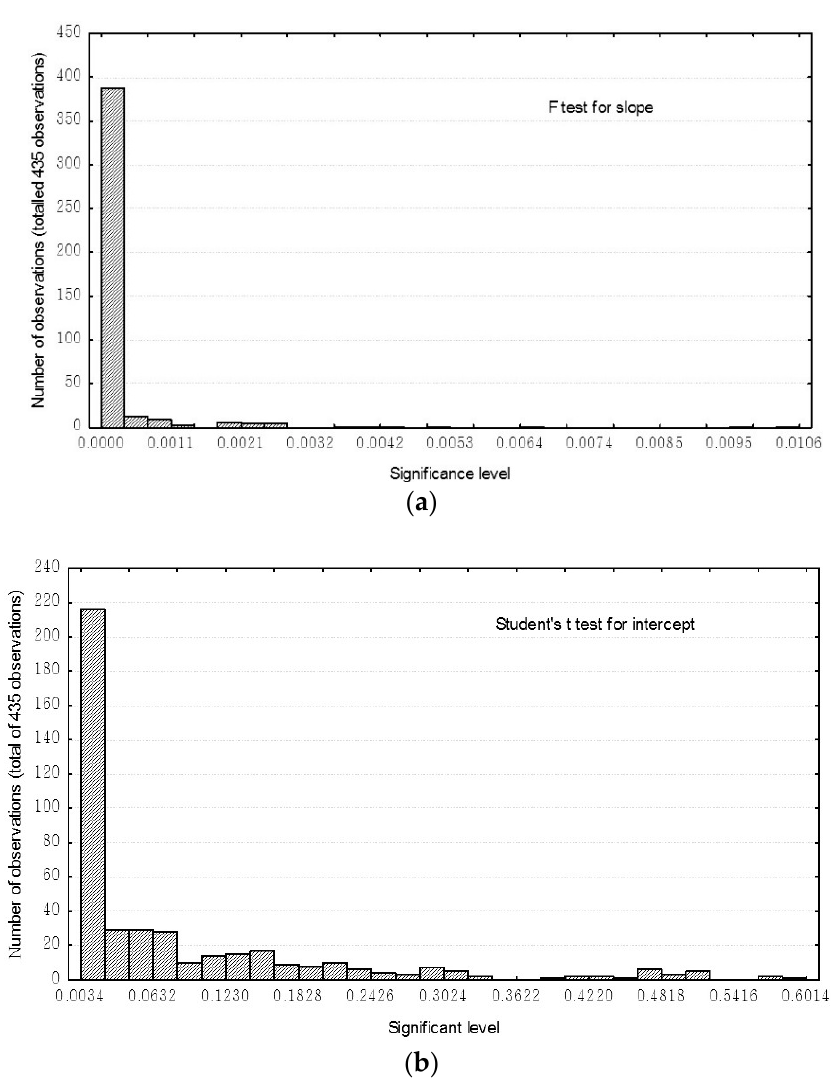
Figure 3. Distributions of significant level of the slope and intercept of the regression of fire probability over IC for periods with different time spans. ( a ) denotes the F test of the slope; ( b ) denotes the t test of the 435 regression.